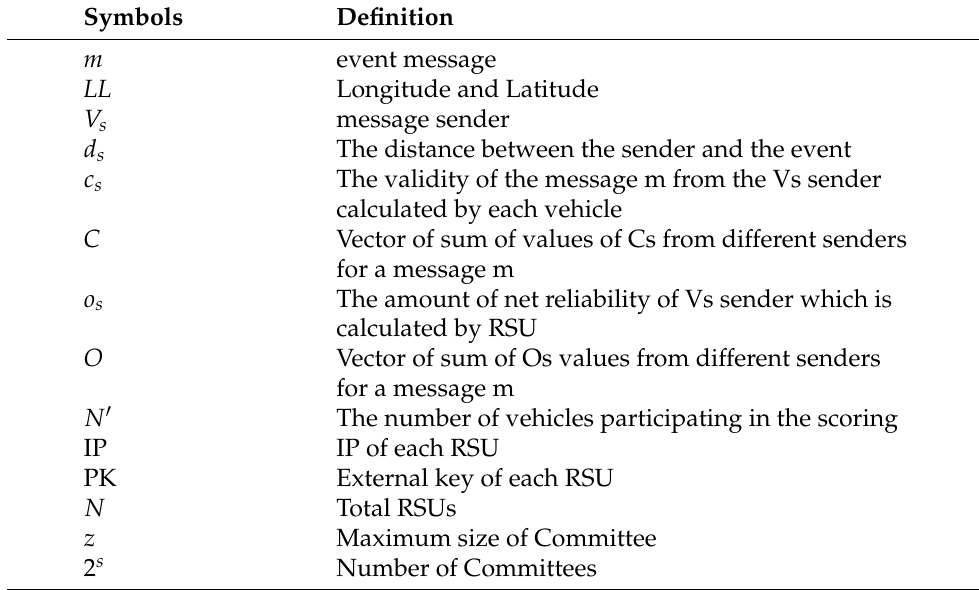
Table 1. Summary of parameters and